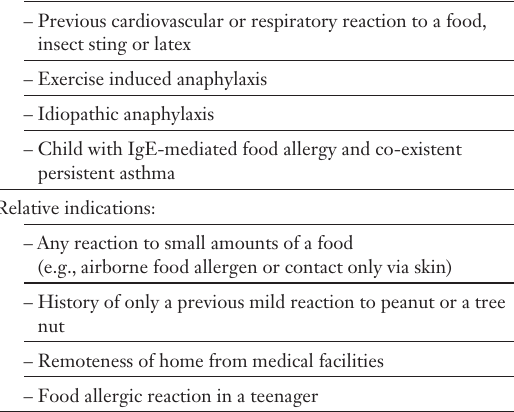
Indications for prescribing self-in- jectable epinephrine. Adapted from Muraro A